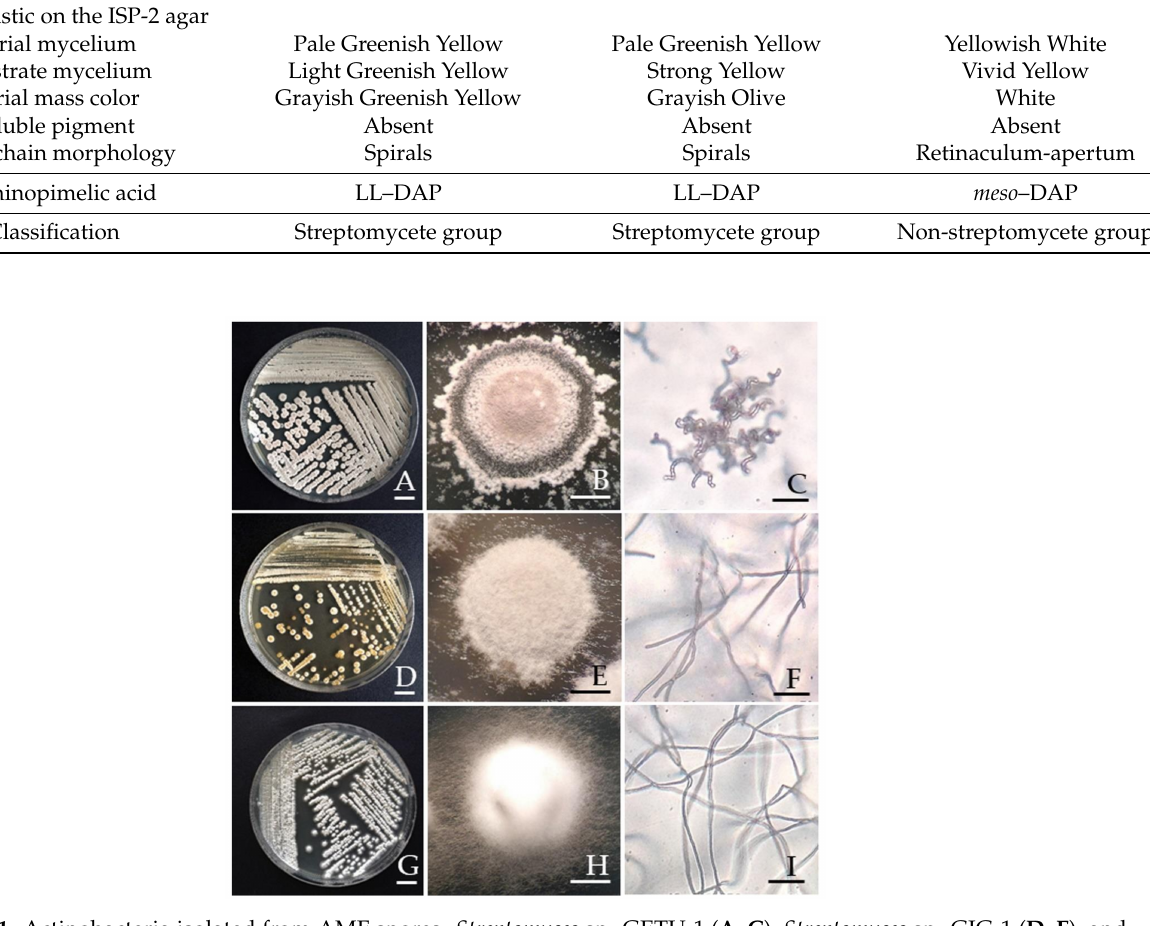
Figure 1. Actinobacteria isolated from AMF spores. Streptomyces sp. GETU-1 ( A – C ), Streptomyces sp. GIG-1 ( D – F ), and Amycolatopsis sp. GLM-2 ( G – I ). Cultures ( A , D , G ) and single colony ( B , E , H ) on the ISP2 agar at 30 ◦ C for 2 weeks on the ISP2 agar. Aerial mycelium under the compound microscope ( C , F , I ). Scale bars: ( A ), ( D ), and ( G ) = 1 cm; ( B ), ( E ),